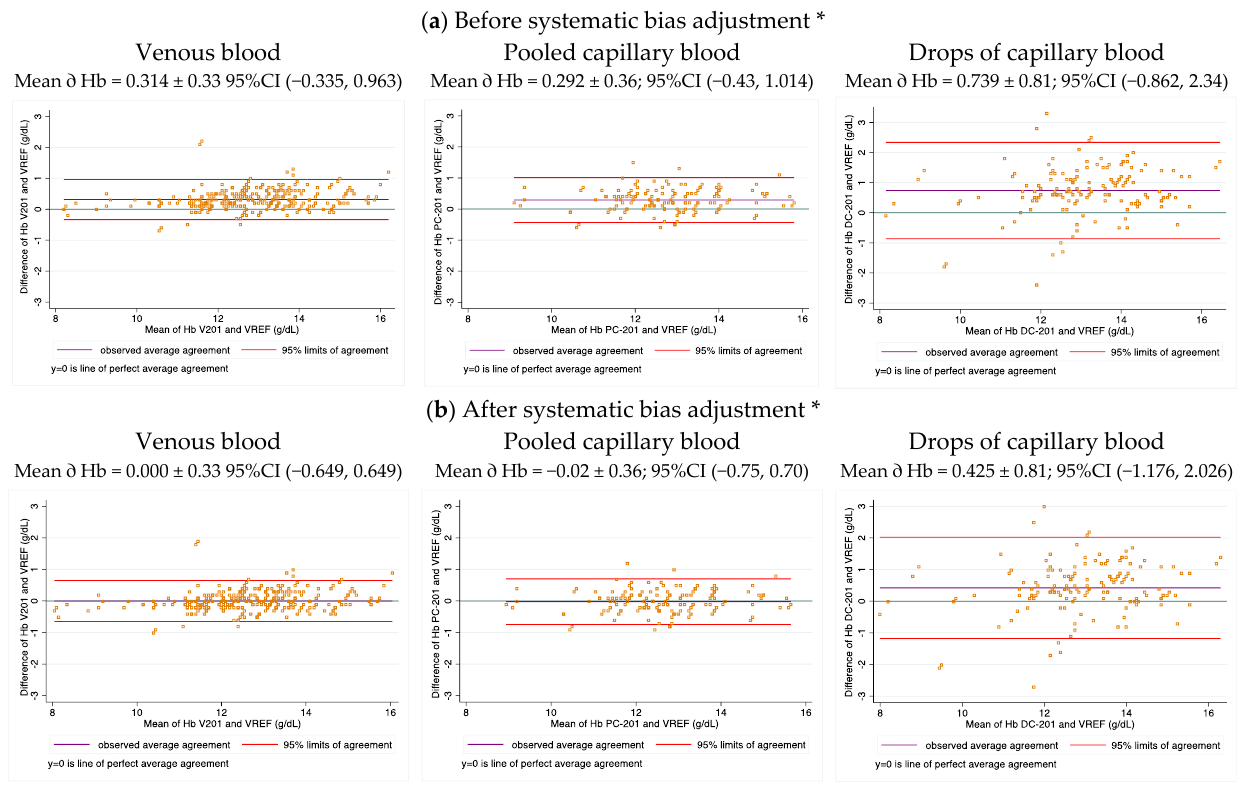
Figure 4. Bland–Altman plots of Hb concentration determined using the HemoCue in different blood sample sources versus using the cyanmethemoglobin method with venous blood. ( a ) Data before adjustment using the systematic bias *, ( b ) data after adjustment *. * The values of the HemoCue were adjusted by subtracting the average systematic bias of 0.314 g/dL estimated in the Bland–Altman plots that compared paired results of venous blood in the HemoCue and with the cyanmethemoglobin method. Abbreviations: V201 = Hb venous analyzed in Hemocue 201. VREF = Hb venous analyzed with the cyanmethemoglobin method. PC-201 = Pooled Capillary analyzed in Hemocue 201+. DC-201 = Drop Capillary analyzed in Hemocue 201+.